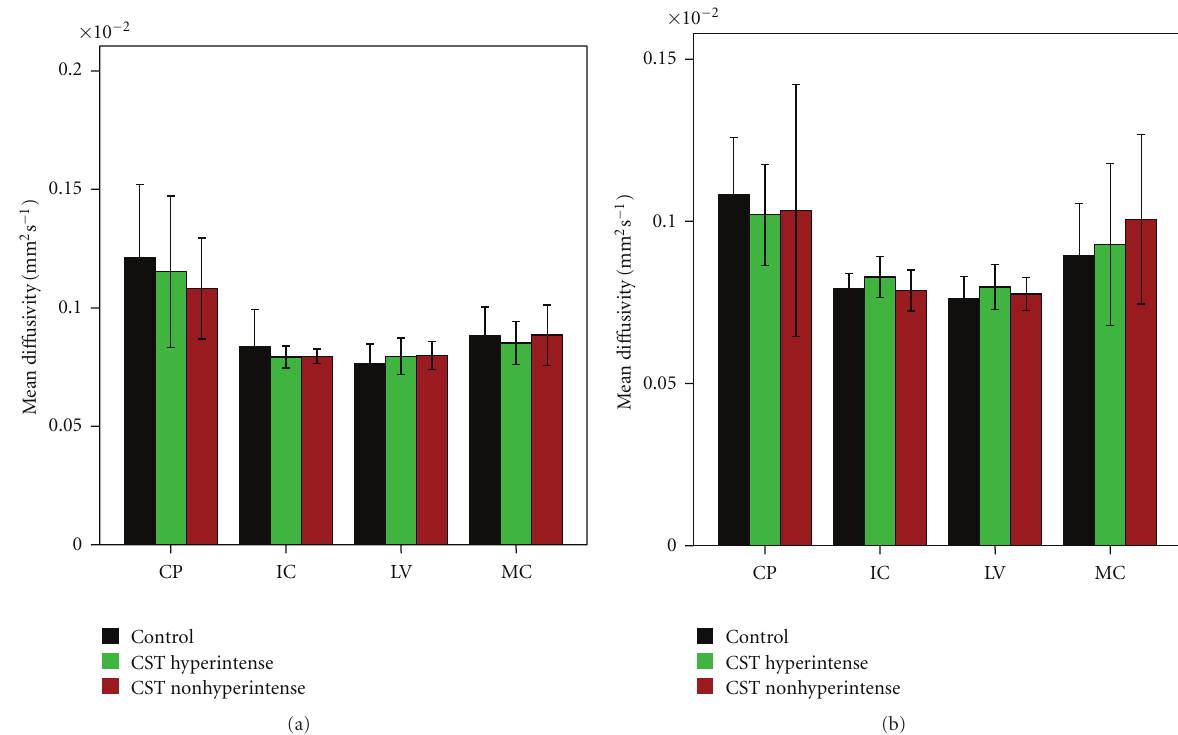
Figure 3: Mean di ff usivity (MA) at four CST levels on left (a) and right (b), revealing no significant di ff erences between groups. Key: CP, cerebral peduncle; IC, posterior limb of internal capsule, LV, centrum semiovale at top of lateral ventricle, MC, subcortical to motor